Question: Reading the figure, is the described quantity rising or falling?
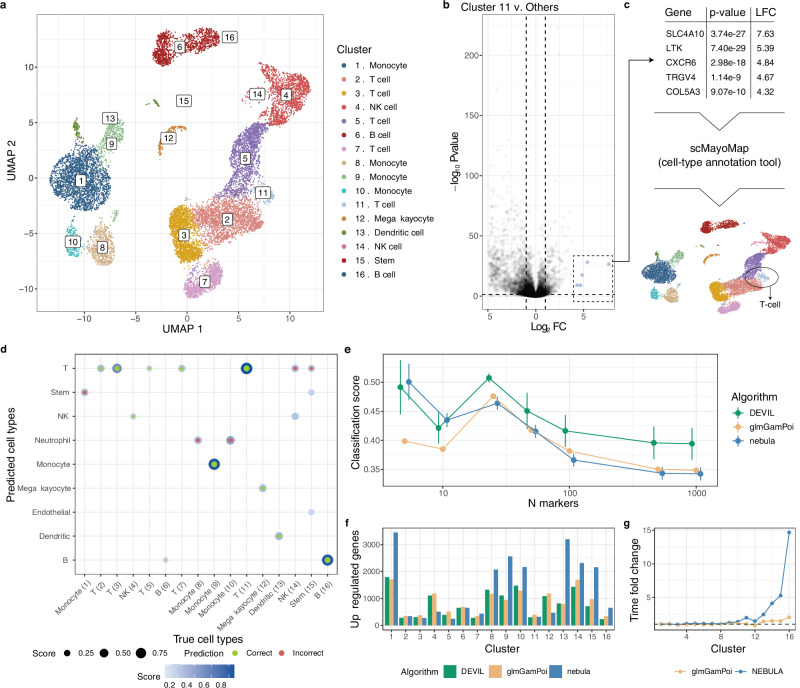
Answer: increasing